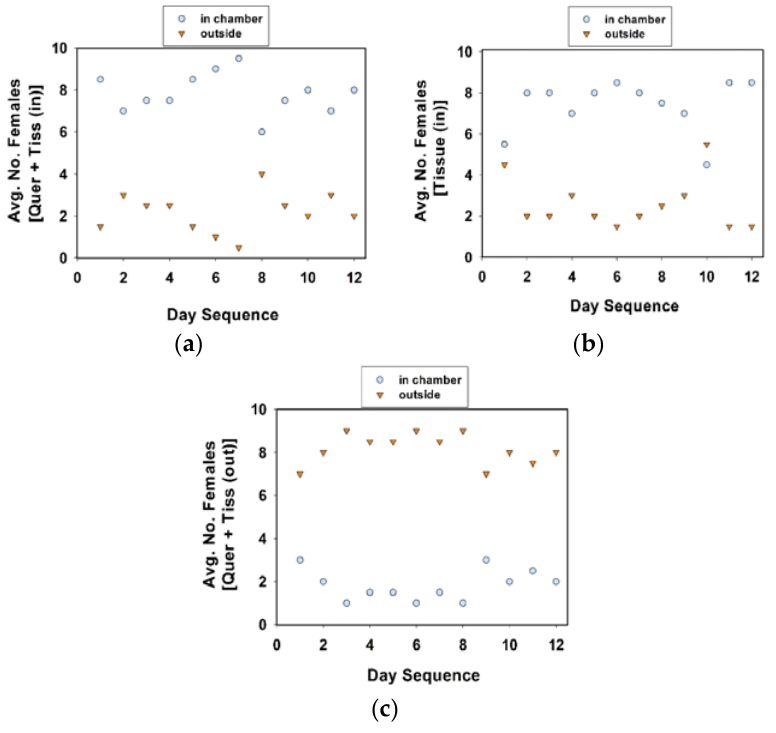
Figure 6. Average number of females inside or outside oviposition chamber. Treatments included quercetin powder and tissue substrate in chamber ( a ), tissue substrate only in chamber ( b ), and quercetin powder in chamber with tissue substrate outside ( c ). A total of 10 females (in each cage) were observed twice each day at approximately 09:00 and 16:00 h, over 12 days. Females were included in experiment 5.